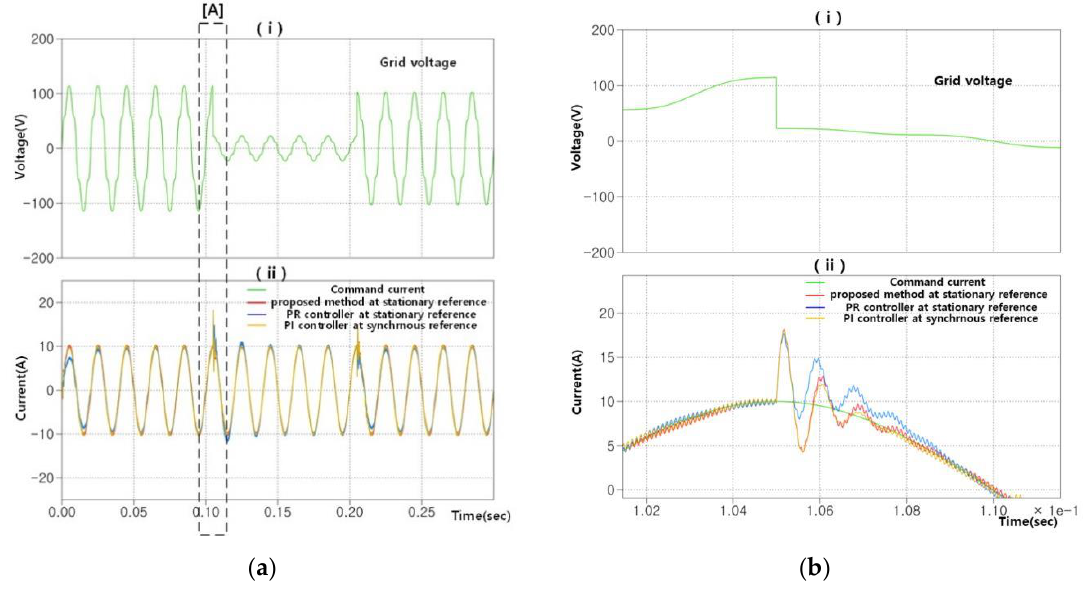
Figure 8. Simulation results of ( i ) grid voltage and ( ii ) grid current when line-to-ground grid voltage fault occurs. ( a ) simulation results at a full time range ( b ) zoomed in simulation results of ( a ).